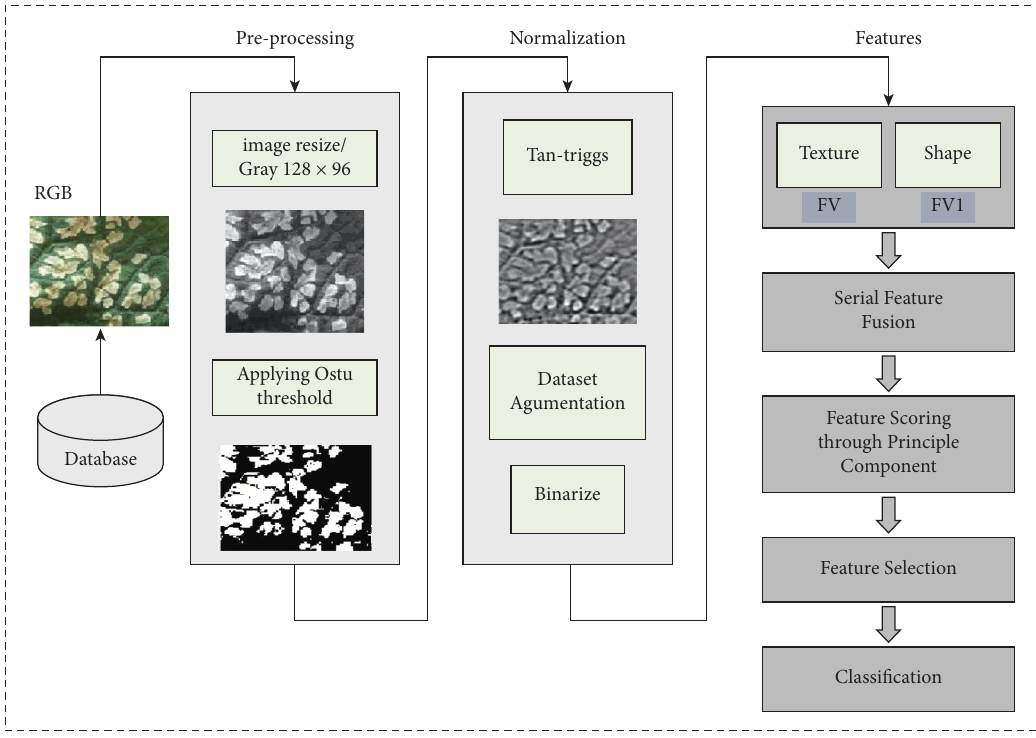
Figure 2: A proposed model for cucumber leaves disease identification and classification.